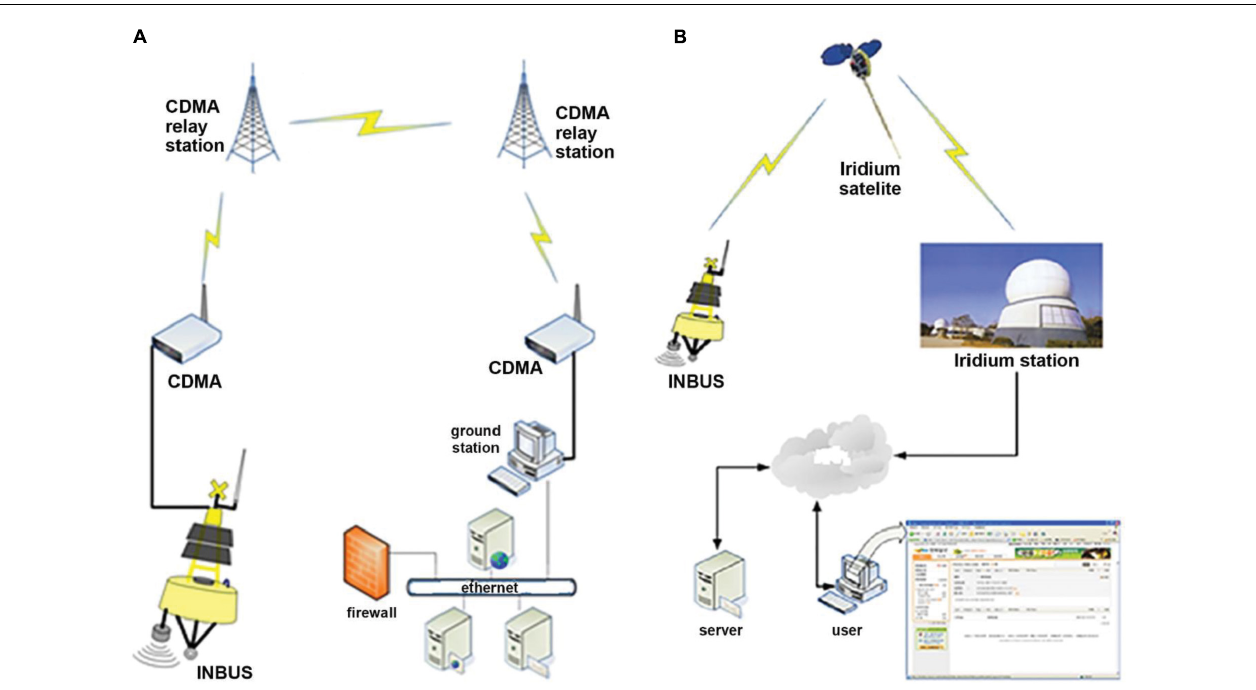
FIGURE 9 | (a,b) Map of the area near Yeongjong-do Island showing location P1 at which INBUS-2 data were measured.